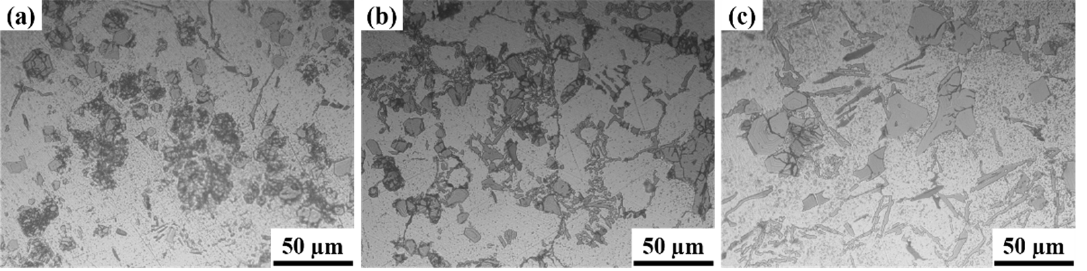
Figure 2. Optical micrographs of the Al-based metal matrix composites with varying concentrations of HEA: ( a ) Al 6063–5 wt.% HEA, ( b ) LM25–5 wt.% HEA, and ( c ) LM25–10 wt.%